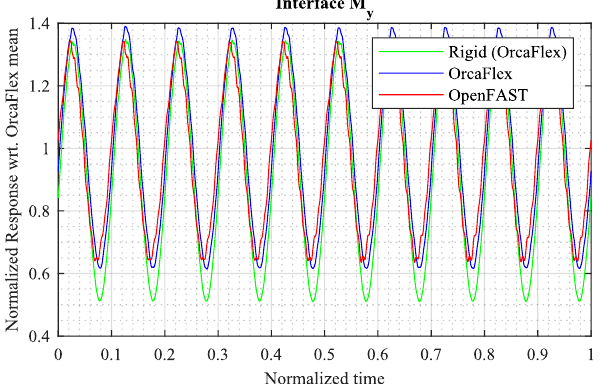
Figure 8. Comparison of the interface moment M y in a regular sea state and with a steady wind